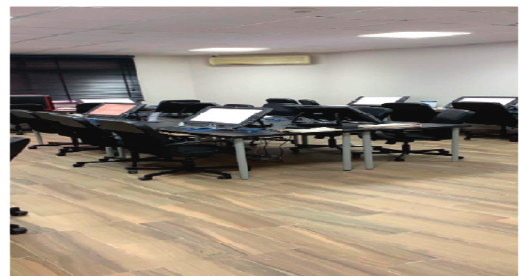
Figure 1: Learning by using zSpace lab (experimental group).